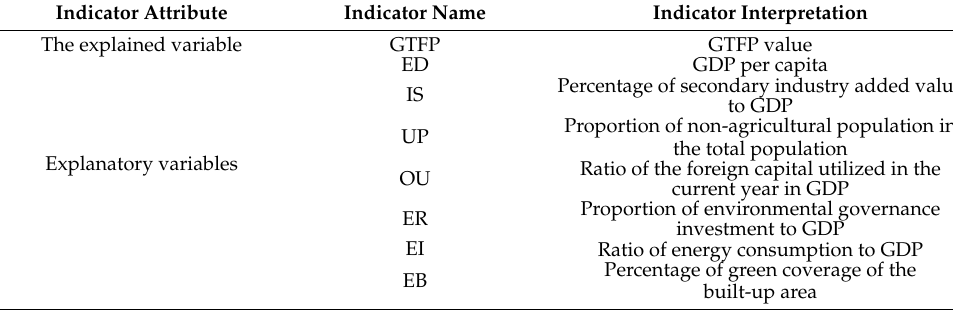
Table 2. Selection of the influencing factor